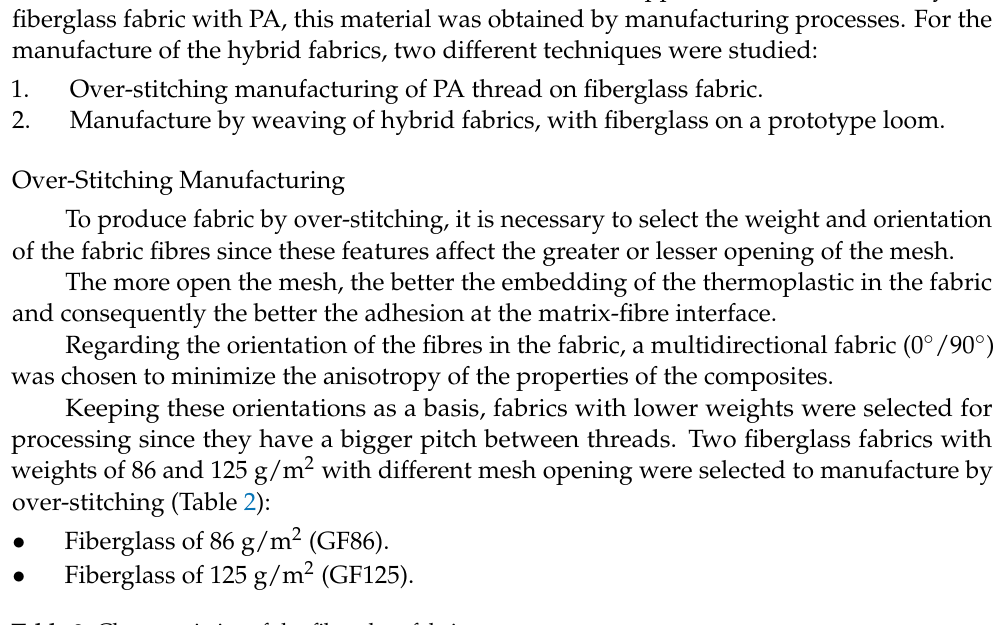
Table 2. Characteristics of the fiberglass fabrics.